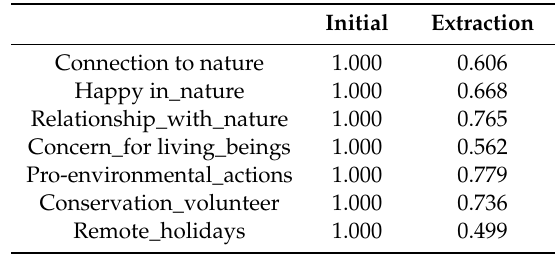
Table 6. Multiple linear correlation coe ffi cient of each variable with the factors.